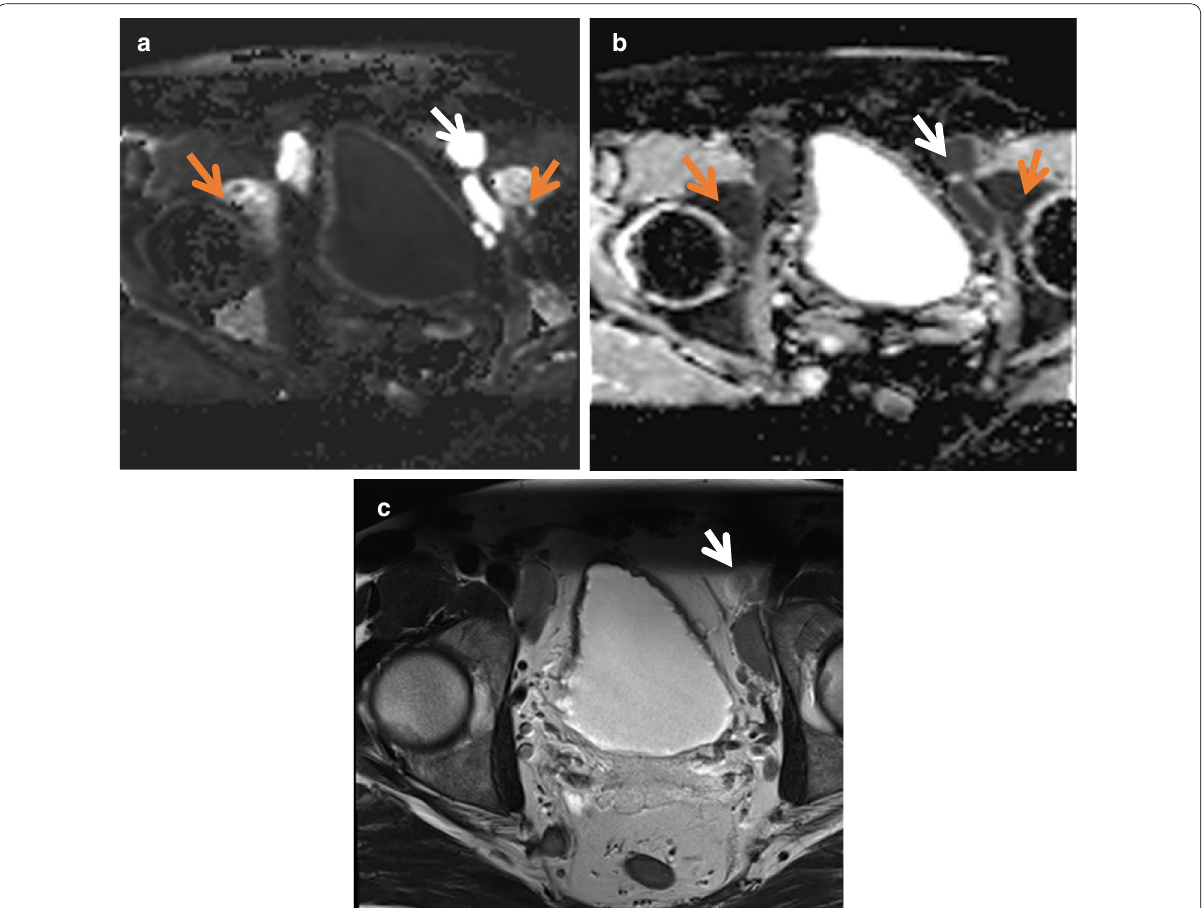
Fig. 26 Lymphadenopathy in a patient with multiple myeloma a Axial DWI and ( b ) ADC images showing diffusion restriction in a rounded lesion to the left of the urinary bladder anteriorly (white arrows) in keeping with nodal metastasis in left external iliac lymph nodes. Diffusion restriction also in the acetabulum bilaterally (red arrows) in keeping with marrow infiltration. c Axial T2W images demonstrate the left external iliac lymph node is iso- to hyperintense relative to surrounding fat which is seen in nodal